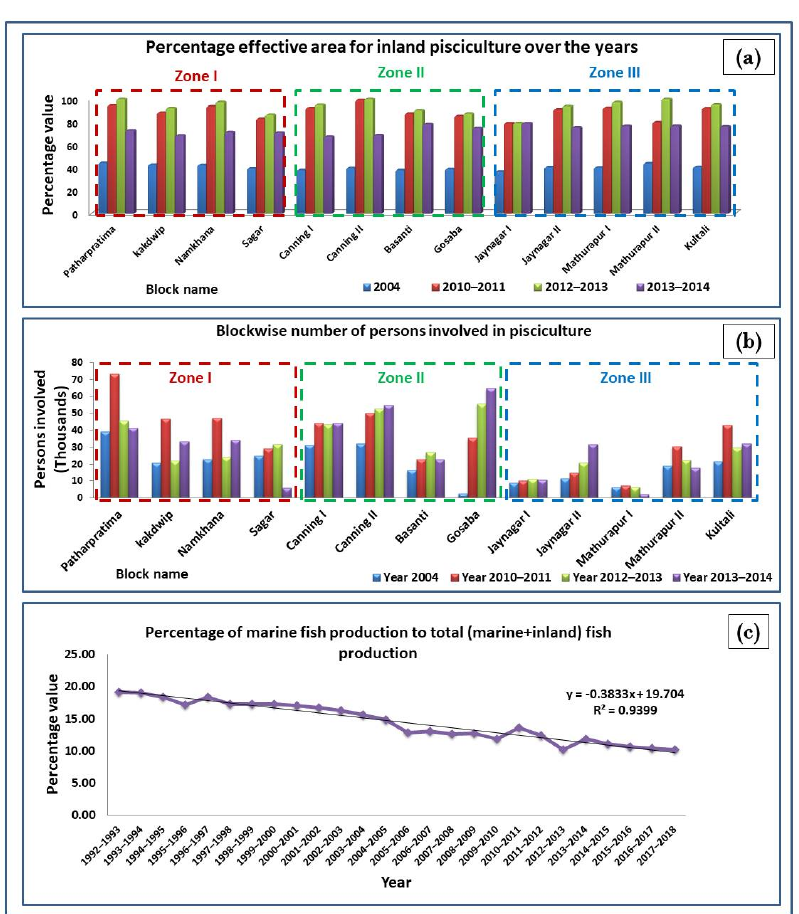
Figure 5. Statistics of fisheries. ( a ) Represents the effective area for inland fisheries over the years in the study area. ( b ) Represents the number of persons involved in inland fisheries. ( c ) Representation of contribution of marine fisheries to total fish production in the study area over the years (1992–2018).